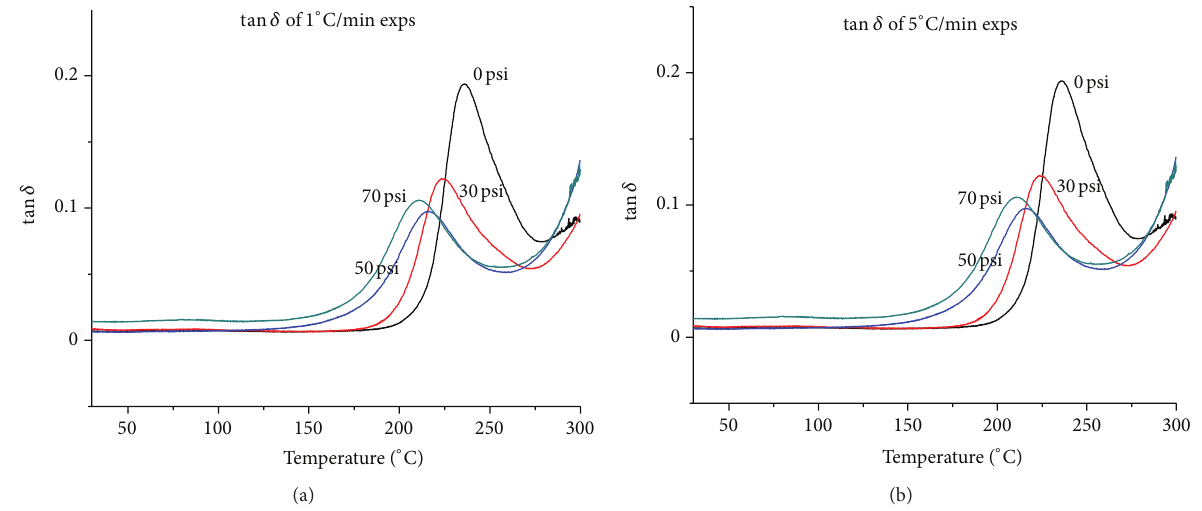
Figure 13: Storage modulus of carbon fiber prepregs—8 plies manufactured at 0, 30, 50, and 70psi in 1 and 5 ∘